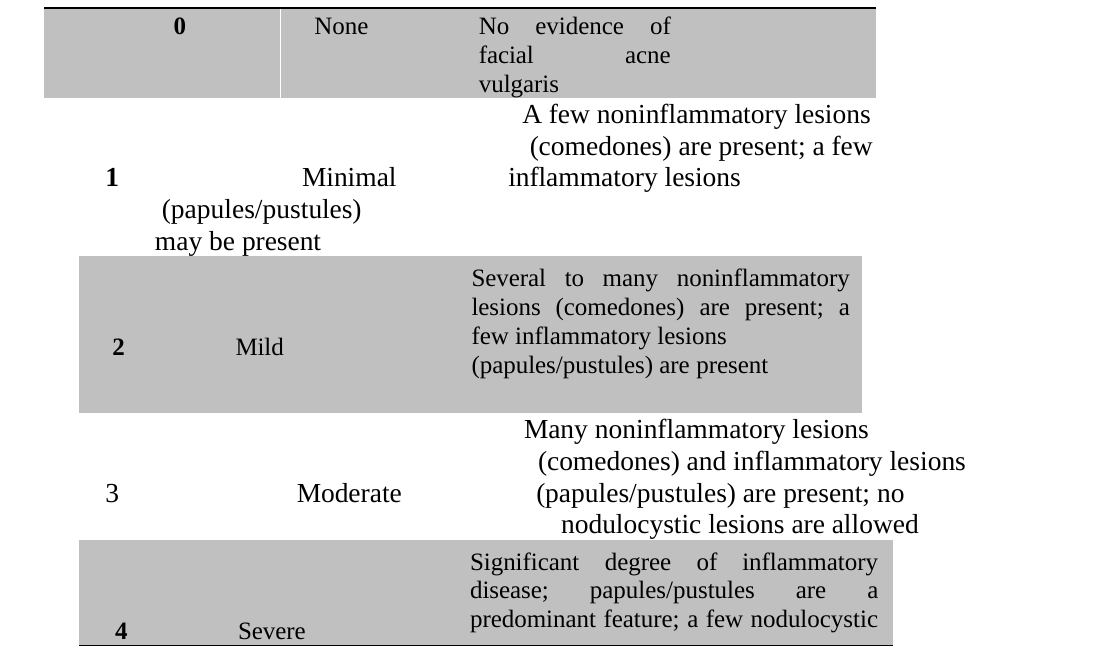
Table (1): The Global Acne Assessment Score GAAS Severity Description GAAS